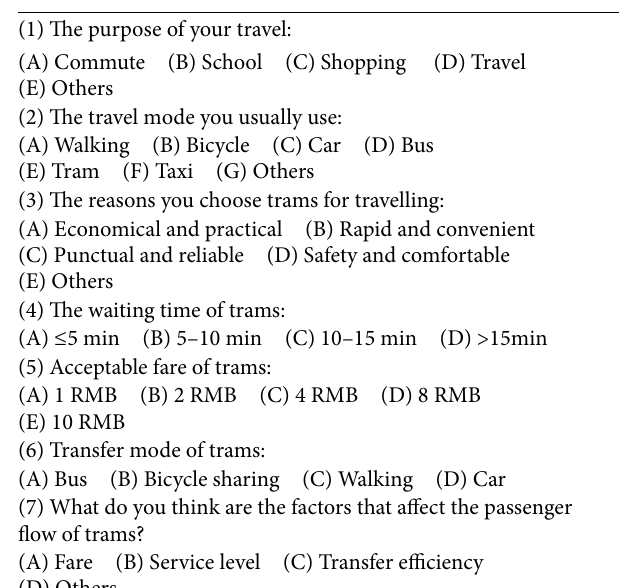
Table 1: Key questions in the study of factors affecting passenger flow of